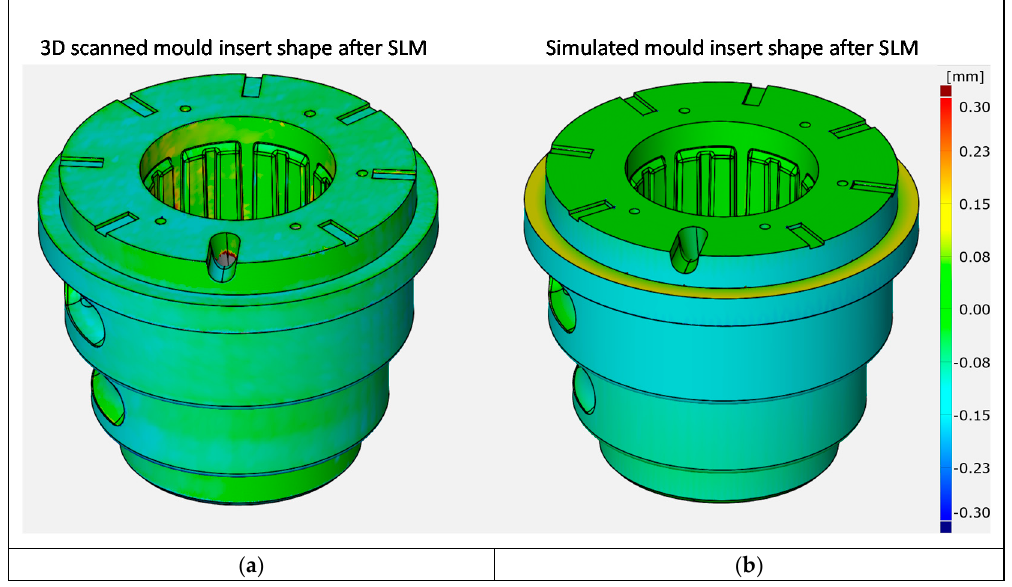
Figure 7. Comparison of the shape accuracy to CAD ideal geometry of the: ( a ) 3D scanned mould insert fabricated by SLM; ( b ) simulated mould insert shape by means of FEA with the method of inherent strains after SLM and support